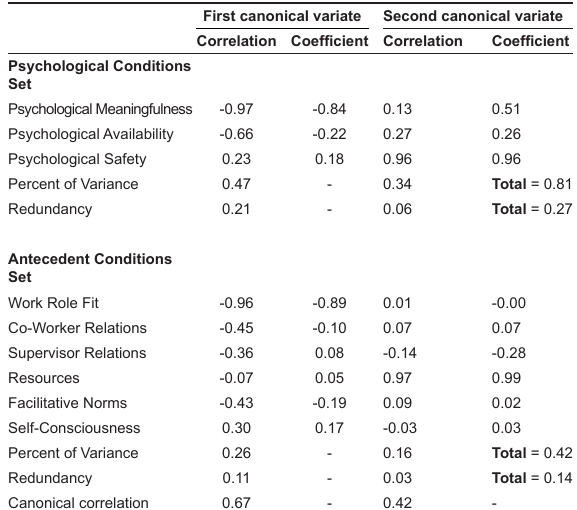
TABLE 4 Results of the canonical analysis: Psychological conditions and antecedents of employee engagement (study 1)